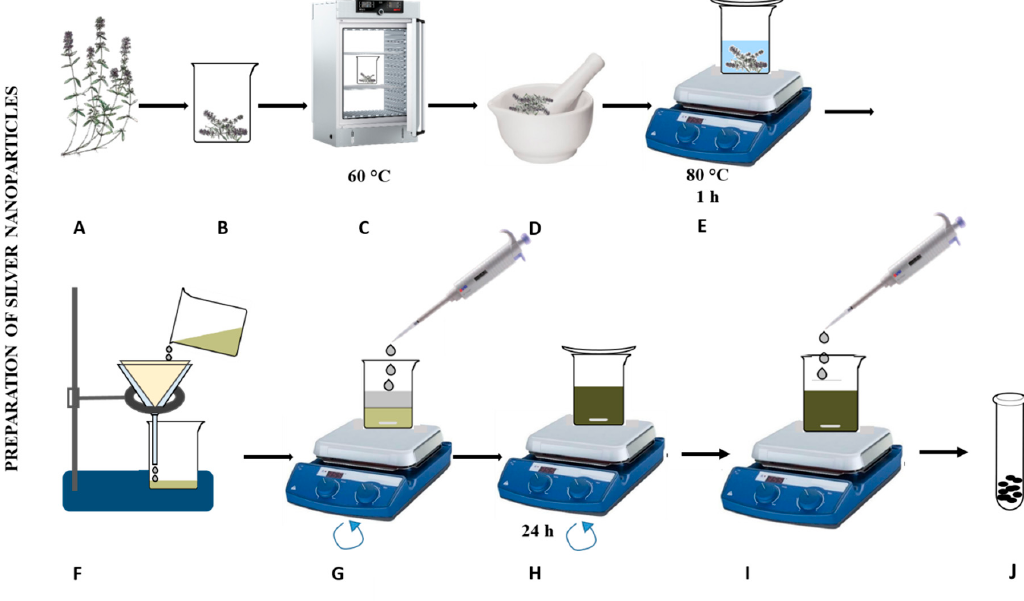
Figure 3 . Preparation and characterization of silver nanoparticles (AgNPs)—a simplified scheme for preparing AgNPs. ( A , B ) The plant was washed in distilled water, ( C ) dried at 60 °C, ( D )